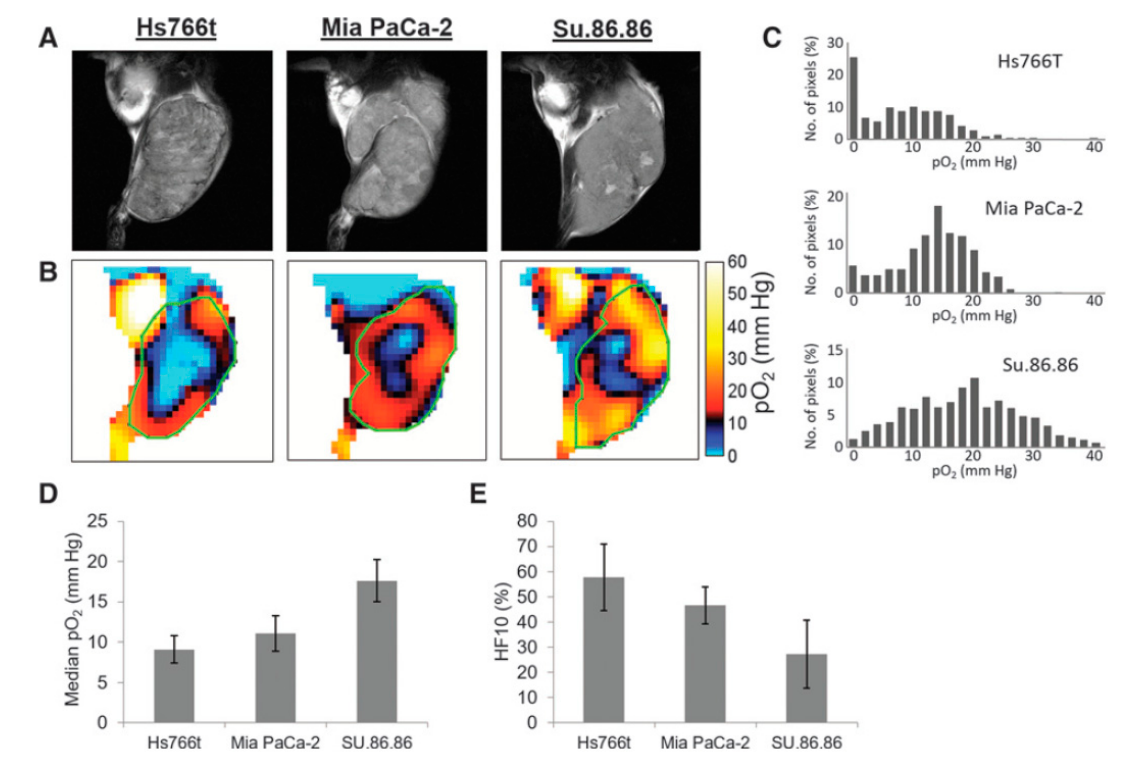
Figure 6. Co-registration of oxygen maps and anatomical images. ( A ), T 2 -weighted anatomical images of Hs766t, MiaPaCa2, and Su.86.86 tumors obtained by MRI. ( B ), Oxygen maps of the three tumors obtained by EPR imaging. ROI of the tumors selected from the anatomical images were overlayed for computing functional parameters. ( C – E ), Histograms of pO 2 distribution in the three tumors ( C ), median pO 2 ( D ), and hypoxic fraction with less than <10 mm Hg pO 2 ( E ) of the pancreatic tumors.